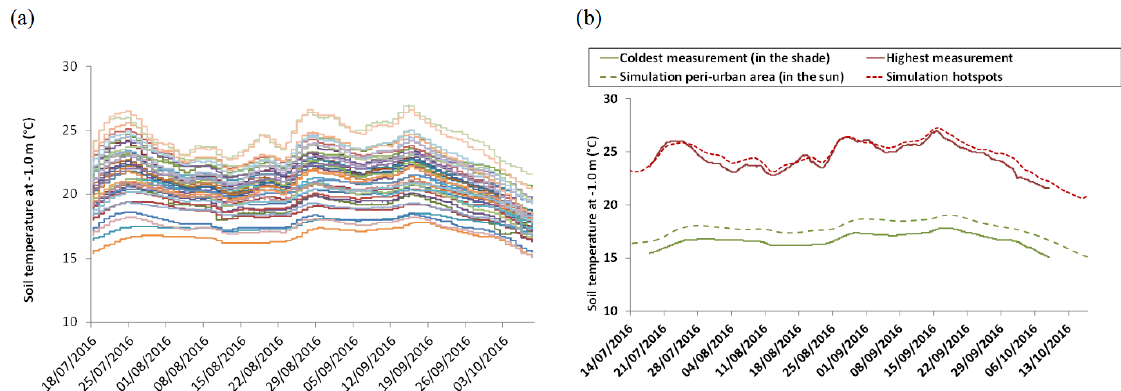
Figure 8. (a) Overview of the soil temperature of all 42 locations and (b) the range of the simulations and the